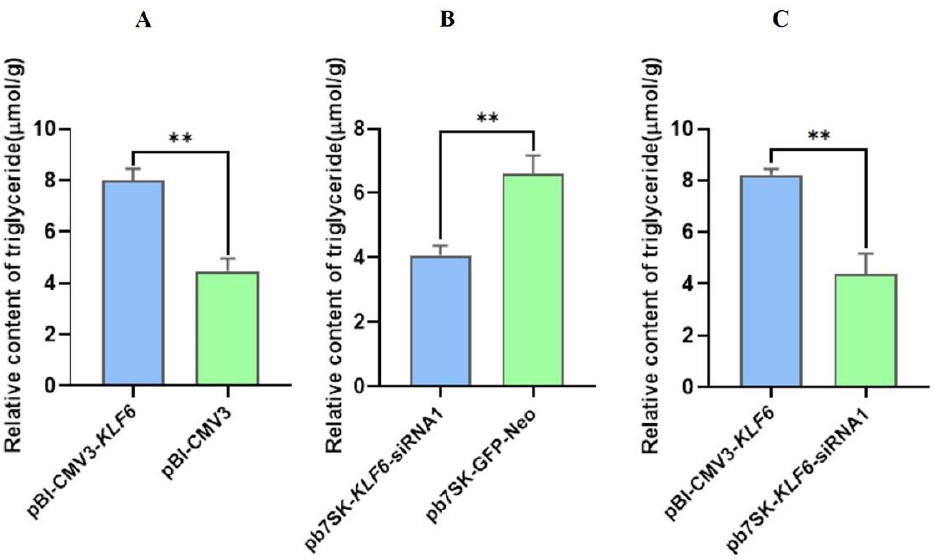
Figure 9. ( A ) Relative contents of TG in BMECs transfected with pBI-CMV3- KLF6 and pBI-GFP- Neo-CMV3. ( B ) Relative contents of TG in BMECs transfected with pb7SK- KLF6 -siRNA1 and pb7SK-GFP-Neo. ( C ) Relative contents of TG in BMECs transfected with pBI-CMV3- KLF6 and pb7SK- KLF6 -siRNA1. ** p <